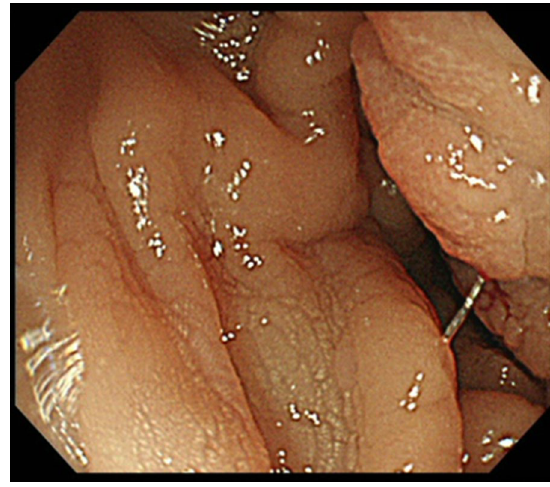
Fig. 2 Colonoscopic findings. The presence of edematous mucosa in the right transverse colon is seen, however, no tumorous lesion is observed